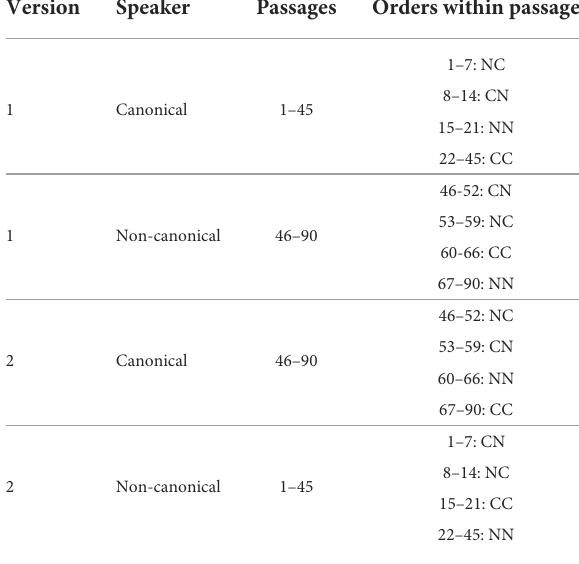
TABLE 1 Counterbalancing of canonical and non-canonical adjective orders across